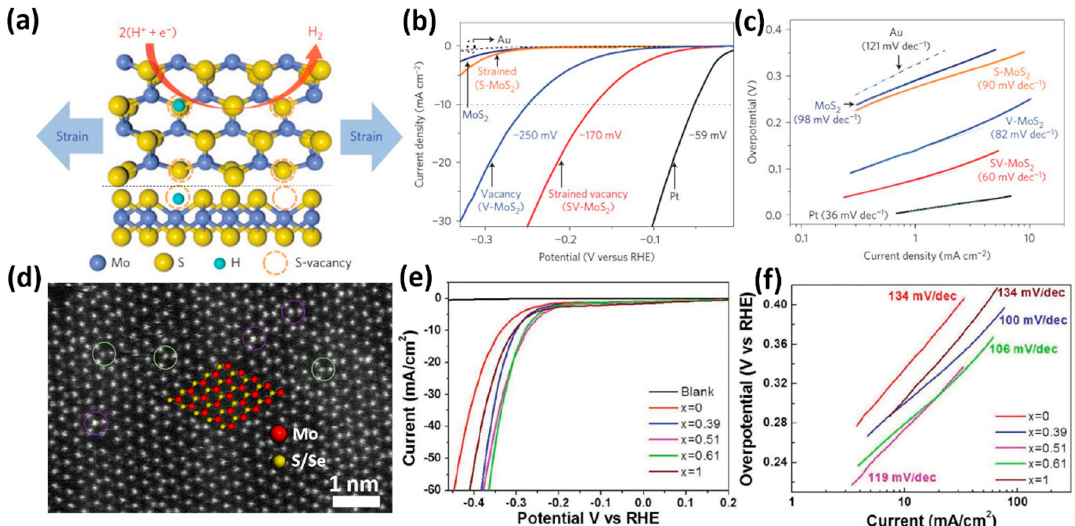
Figure 8. ( a ) Schematic of the top and side views of MoS 2 with strained S-vacancies on the basal plane [68]. ( b ) Polarization curves and ( c ) Tafel plots of various MoS 2 catalysts as indicated [68]. ( d ) HRSTEM image of monolayer MoS 2(1 − x) Se 2x alloy with x = 0.39 [69]. ( e ) Polarization curves and ( f ) Tafel plots of monolayer MoS 2(1 − x) Se 2x with different Se contents [69]. Reproduced from [68] with